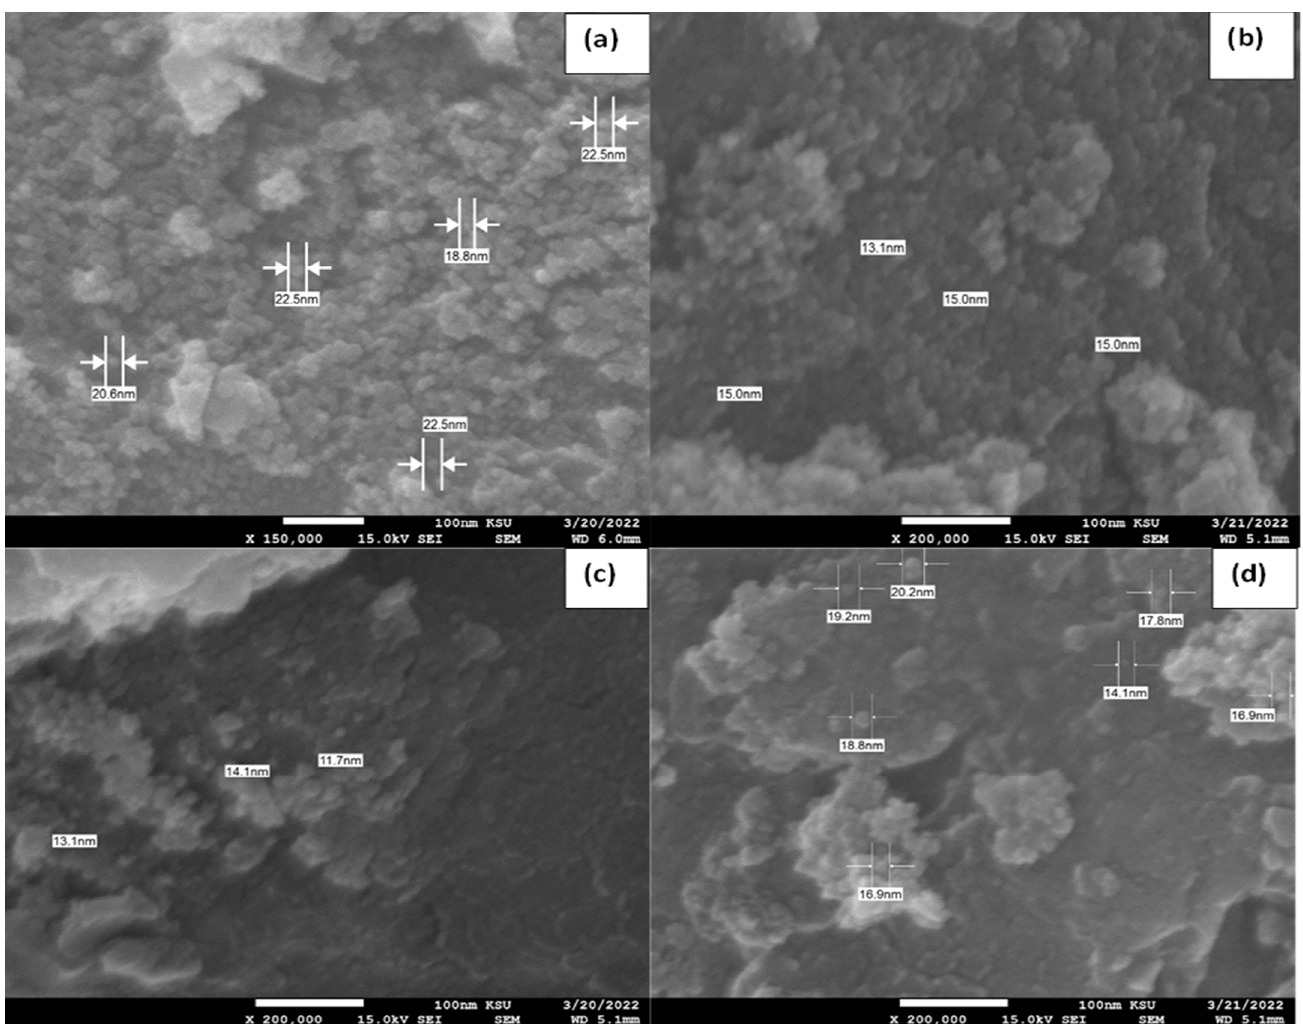
Figure 1. SEM results of the prepared ( a ) Al 2 O 3 nanoparticles; ( b – d ) Al 2 O 3 doped by CuO NiO, and CoO, respectively.